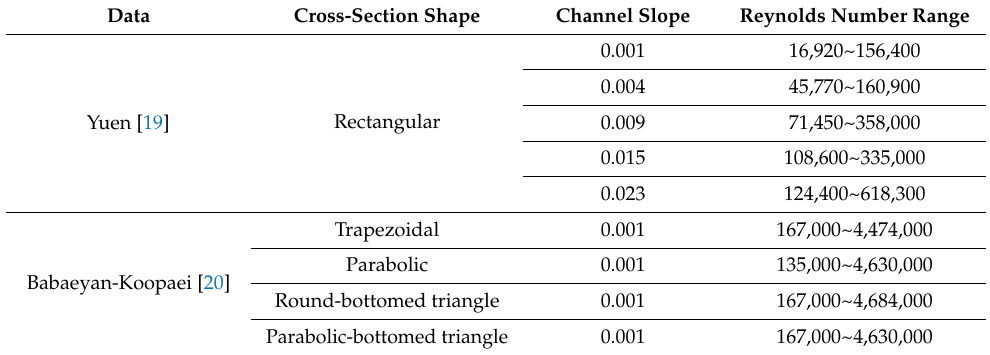
Table 1. The range of Reynolds numbers with the cross-section shape and the channel slope.